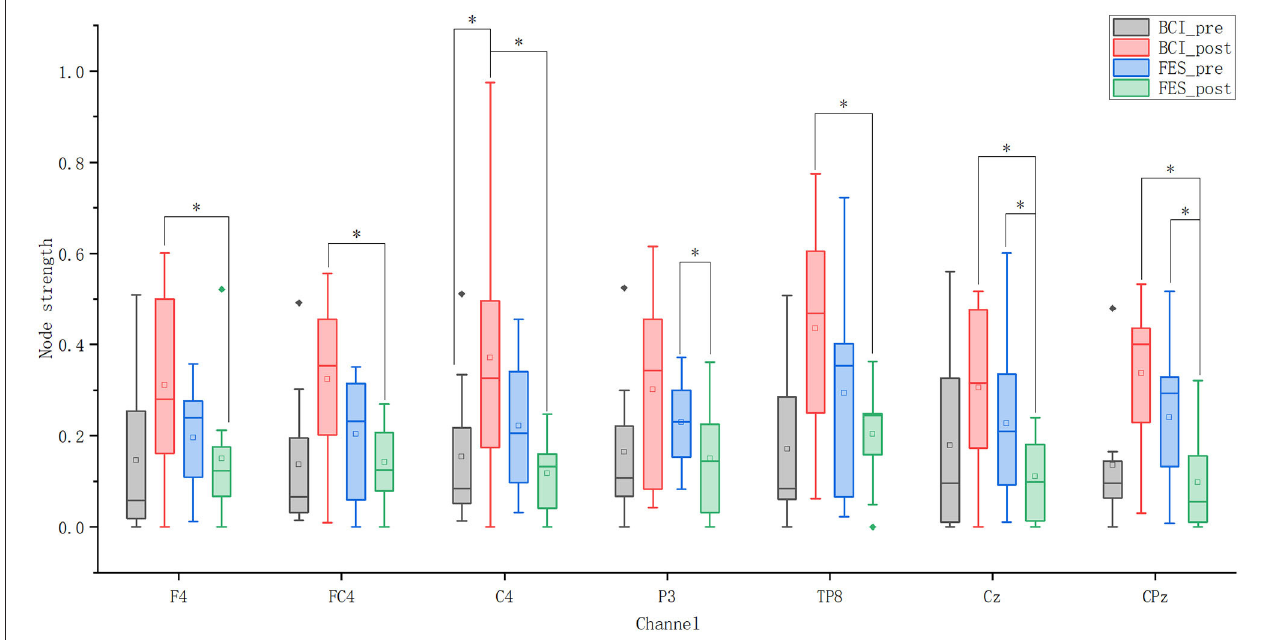
FIGURE 7 | Node strength of seven nodes. Solid diamonds indicate outliers. Hollow squares represent mean values. * p < 0.05.